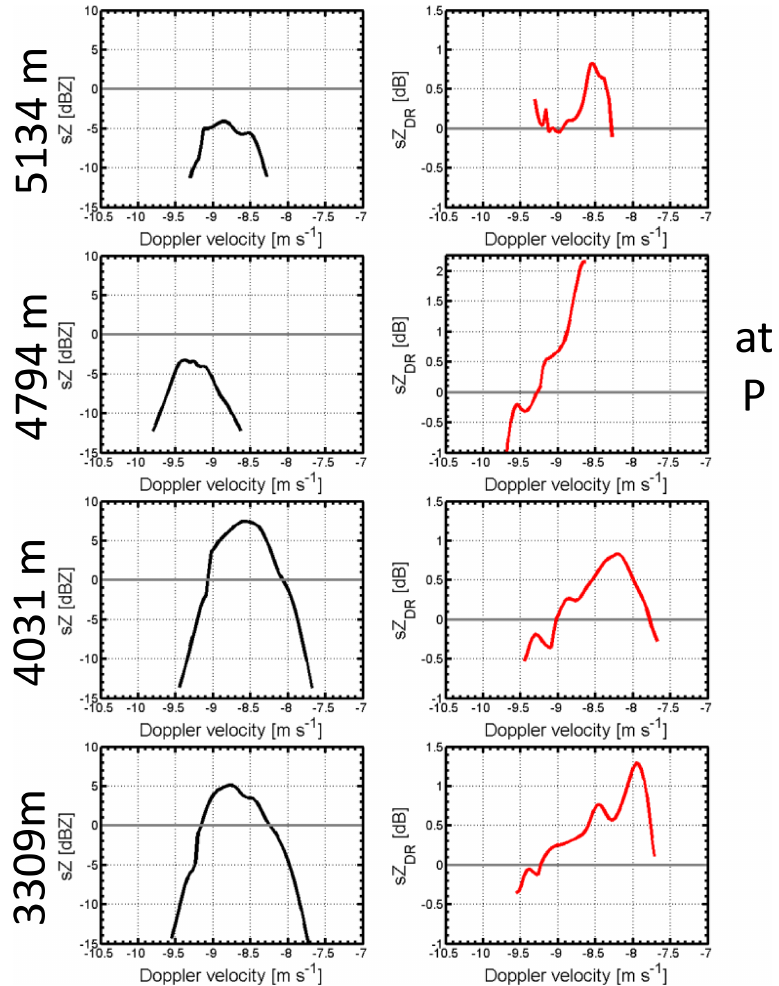
Figure 13. Along the fall streak at 11:47:30UTC rearranged sZ and sZ DR at four different altitudes. The left panel shows Doppler spectra at 5134, 4794, 4031, and 3309m. The right column displays the corresponding spectral differential reflectivity at the same heights. All spectra are at 45 ◦ elevation and averaged over 3 consecutive time bins ( ∼